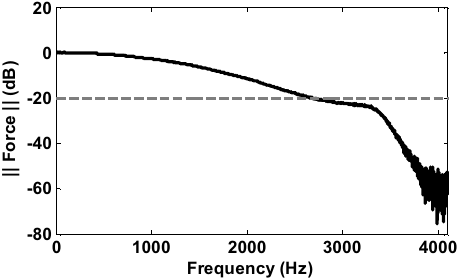
Fig. 13. The magnitude of a typical force at Point 1 (——) as well as the level at which the force magnitude drops by 20 dB (– –